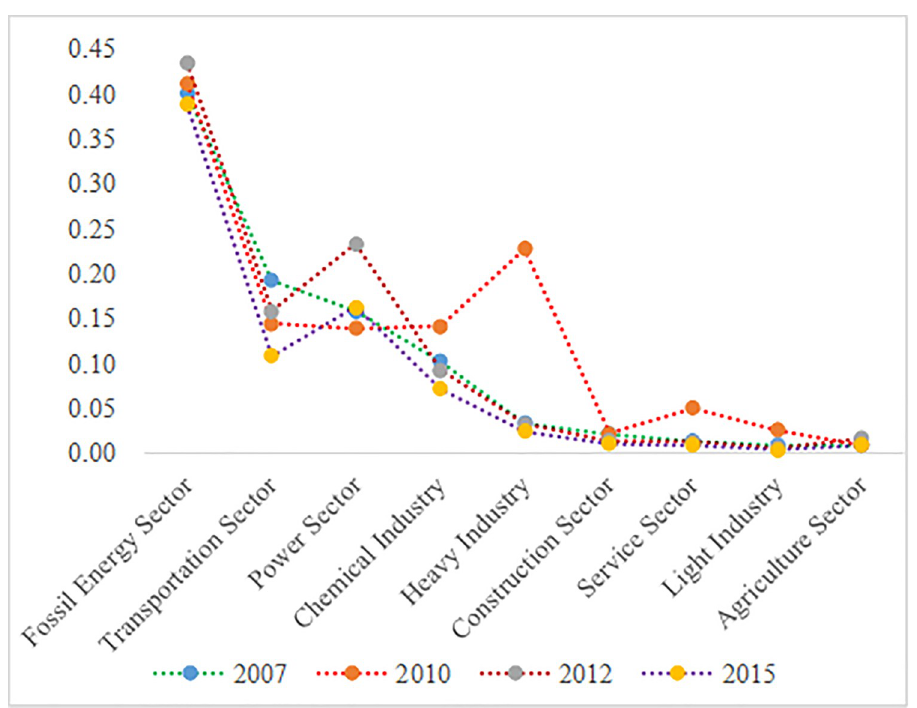
Fig 6. Direct consumption coefficient of fossil energy by various industries.